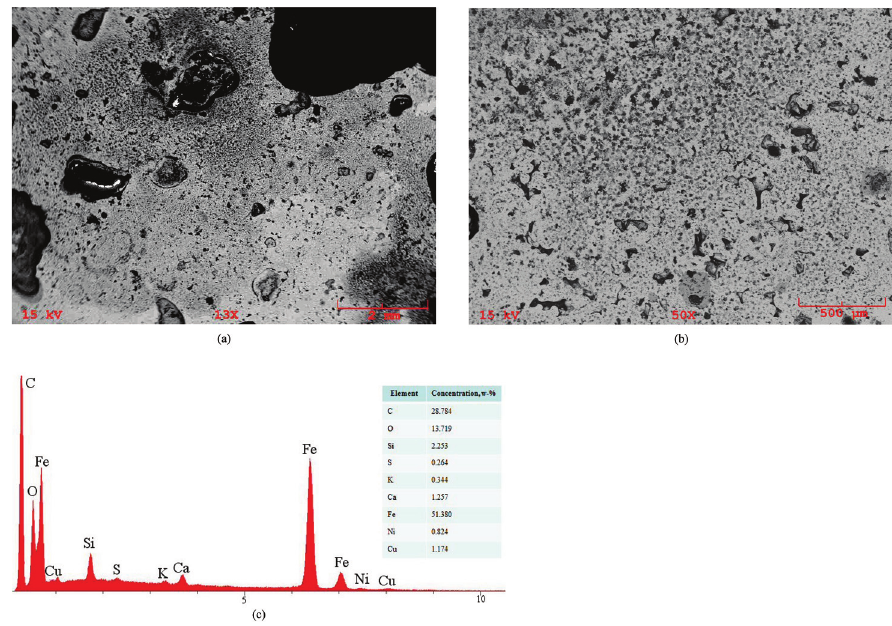
Figure 1: (a) and (b) SEM micrographs of solidified sponge iron after reduction by solid reductant (coal), (c) EDS analysis of matrix illustrated in